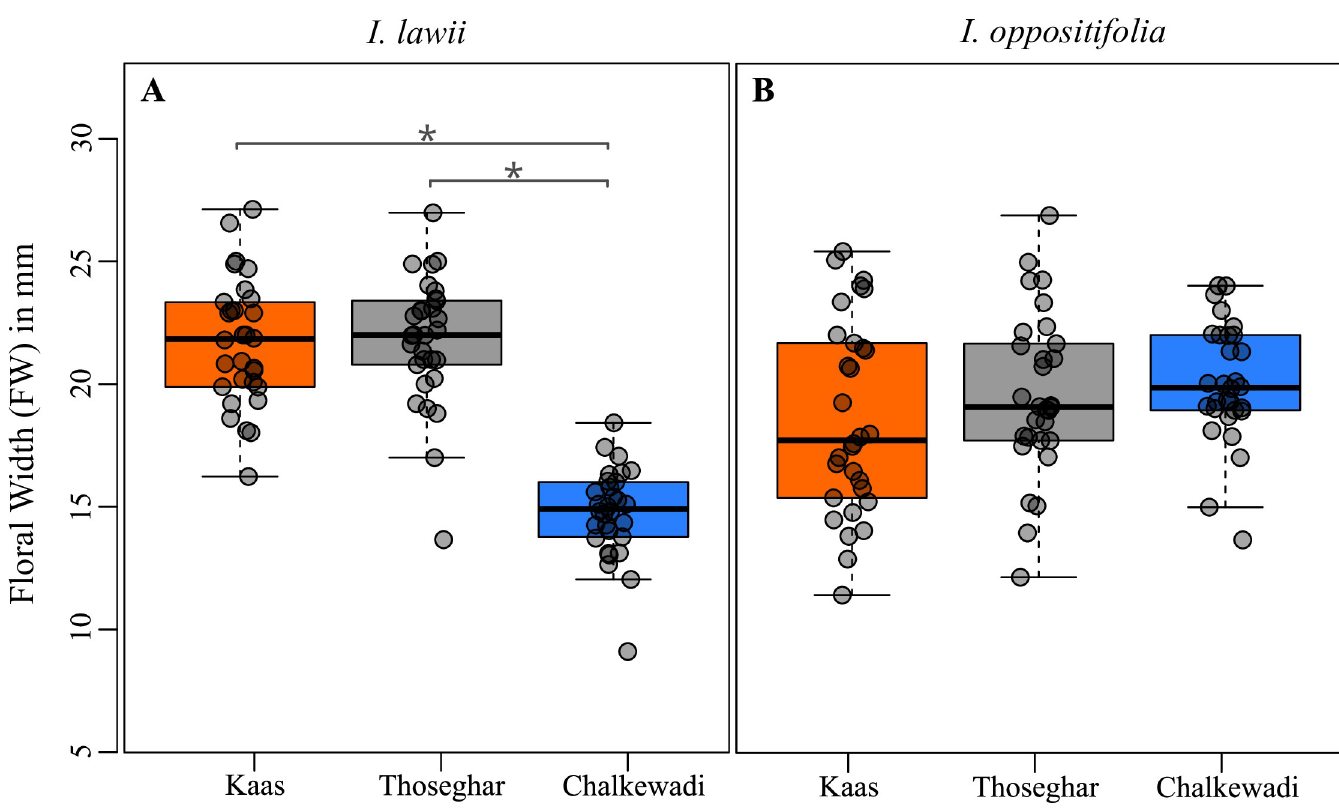
Fig 2. Flower size represented by flower width (FW) across the three wild populations from the three plateaus. (A) I . lawii; and, (B) I . oppositifolia . Boxplots with the median and interquartile range for flower width are presented for 30 individuals from each species and plateau. An asterisk indicates a significant difference (p < 0.05) in flower width between